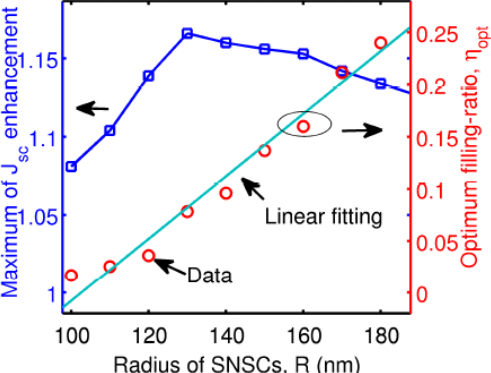
Figure 10. Maximum J sc enhancement (blue squares) and optimum filling ratio (red circles) as a function of the radius of single nanowire solar cells (SNSCs). The light green line is the linear fitting for the relationship between η opt and R . Reprinted with permission from